Question: Write a single sentence explaining what this figure depicts.
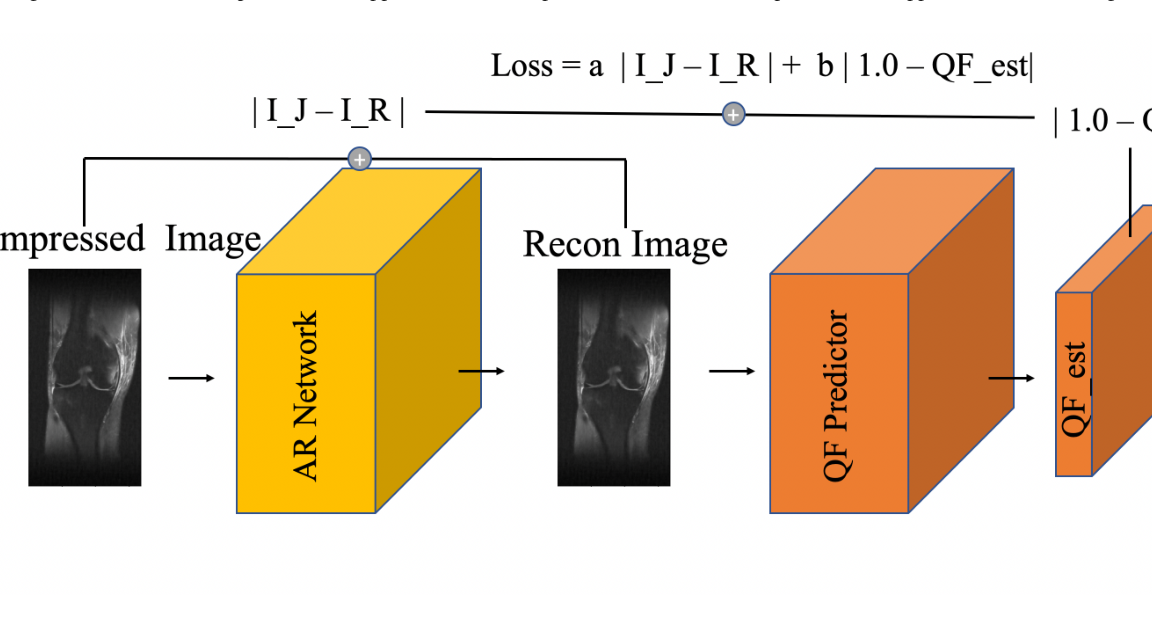
Answer: Pipeline for using QF Predictor as a loss function integrated into the image reconstruction networks.